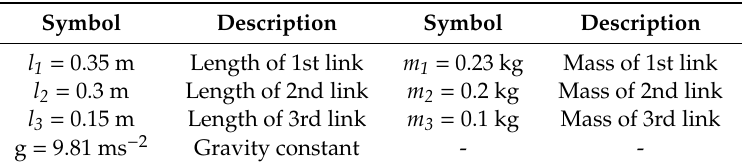
Table 1. Parameters of the 3-DOF planar